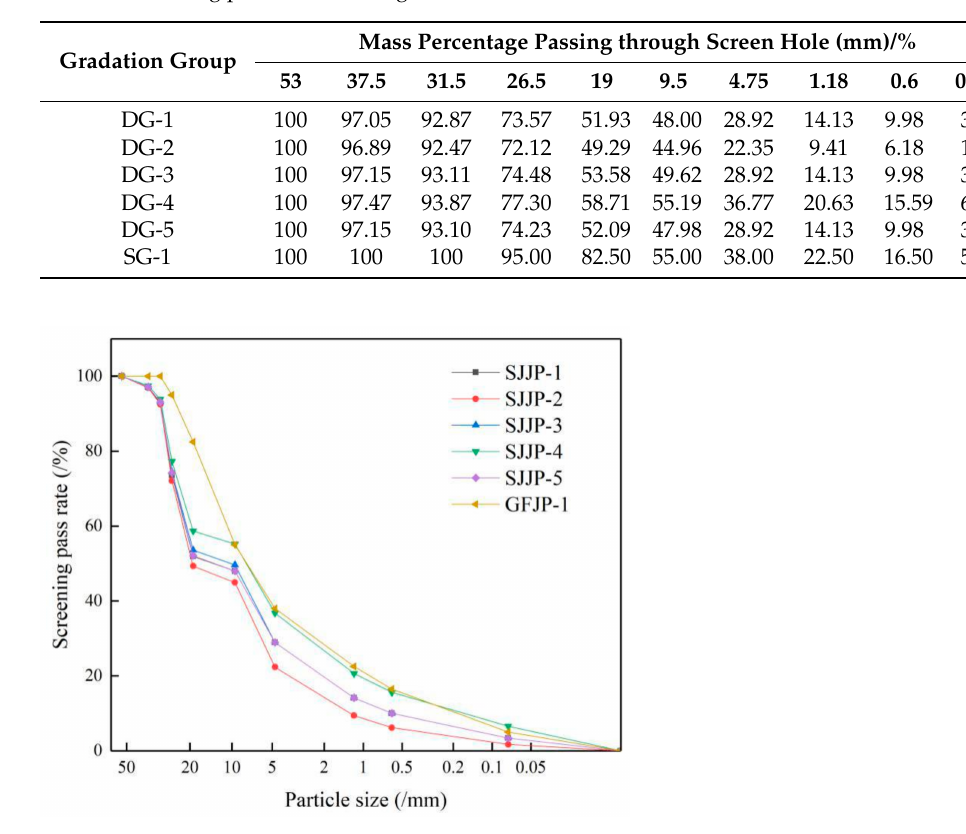
Figure 9. Gradation graph for all